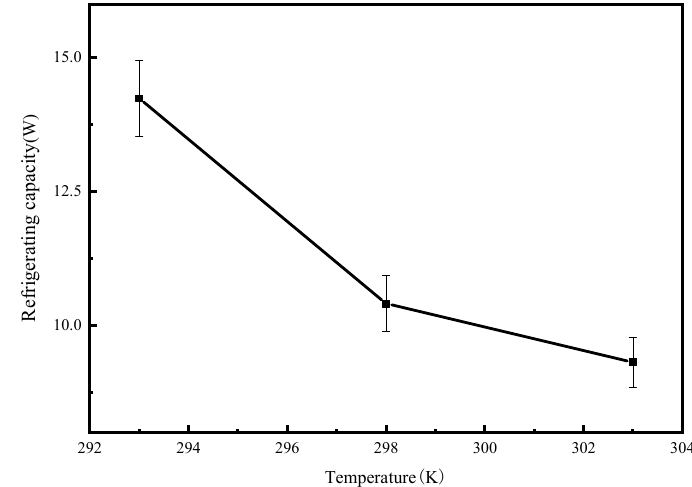
Figure 14. Cooling capacity of the system at different adsorption temperatures.